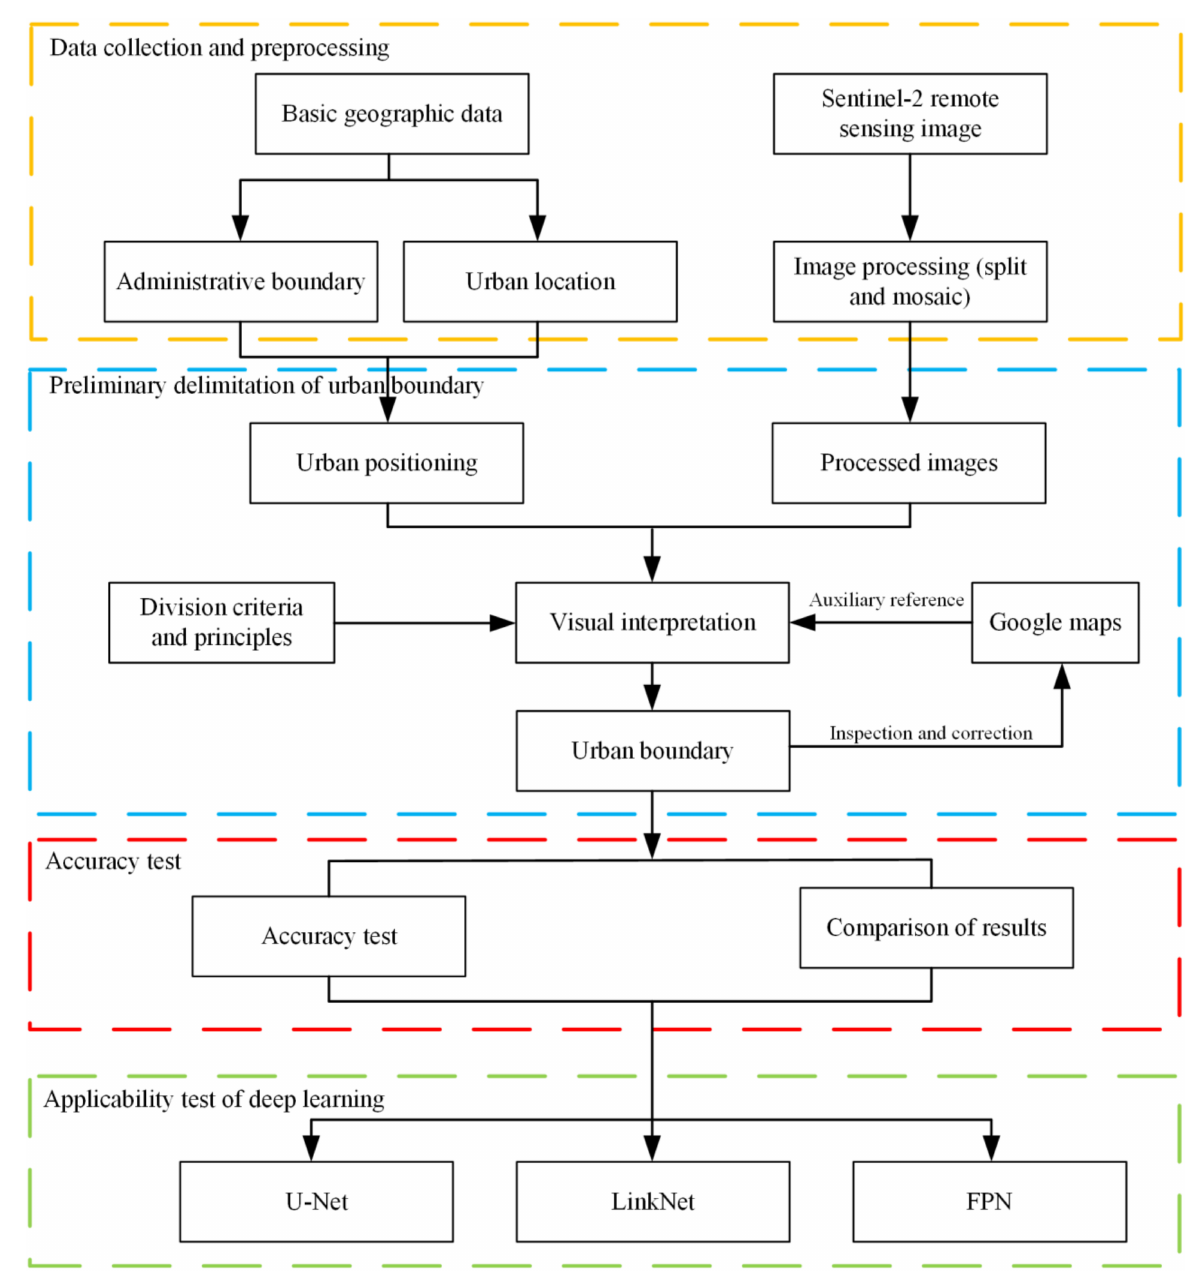
Figure 2. Flow chart of delimiting urban boundary